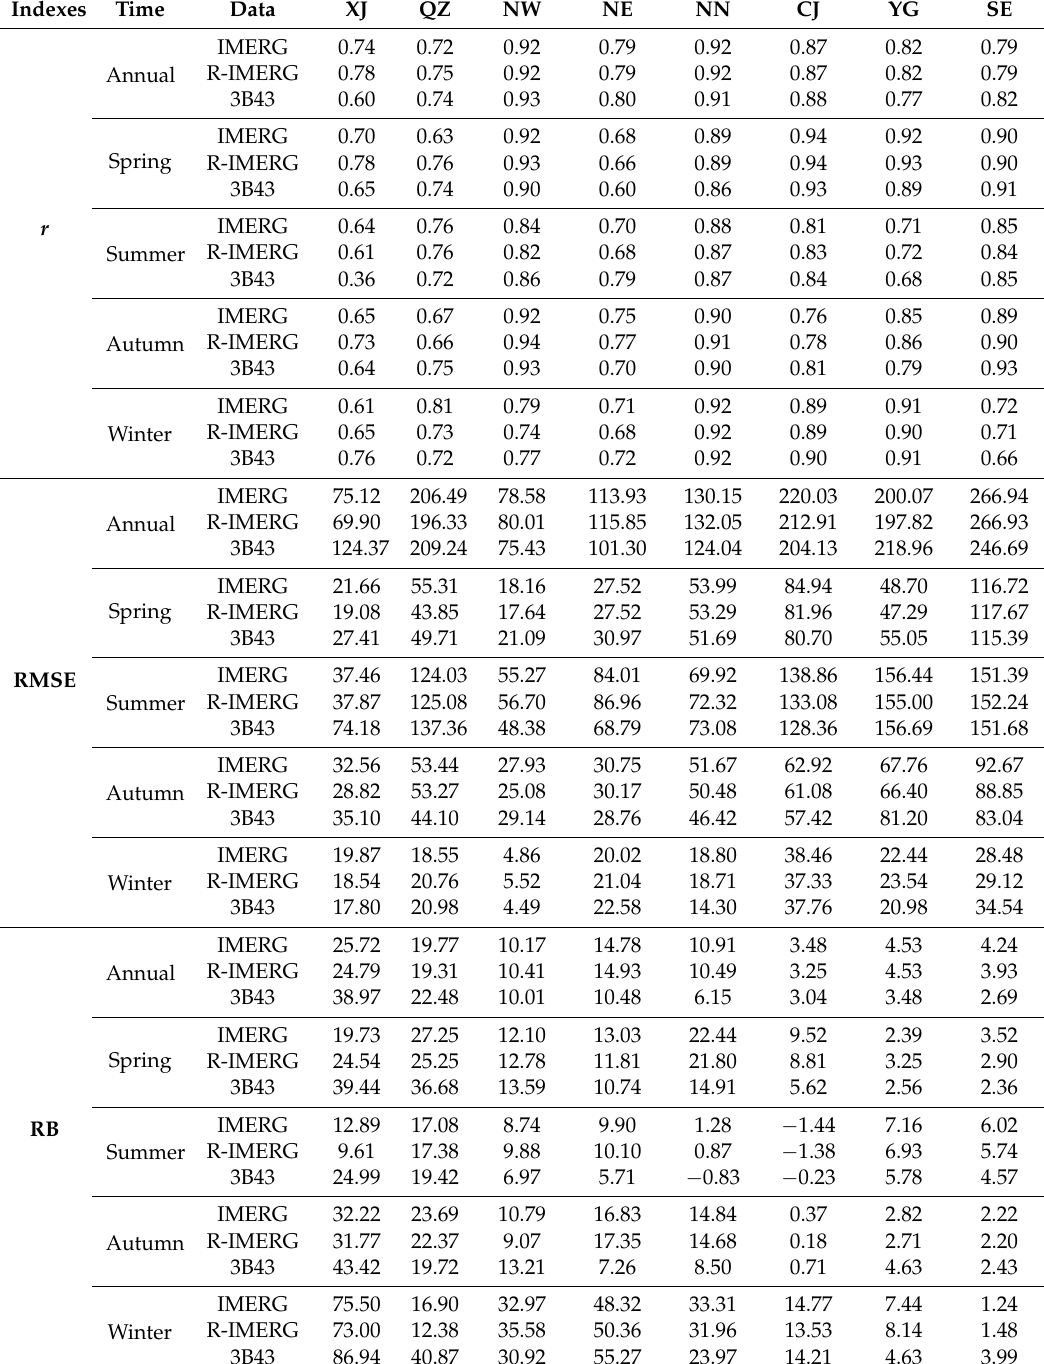
Table 1. r , RMSE, and RB values of annual and seasonal precipitation estimates derived from IMERG, R-IMERG, and TRMM 3B43 products over the eight